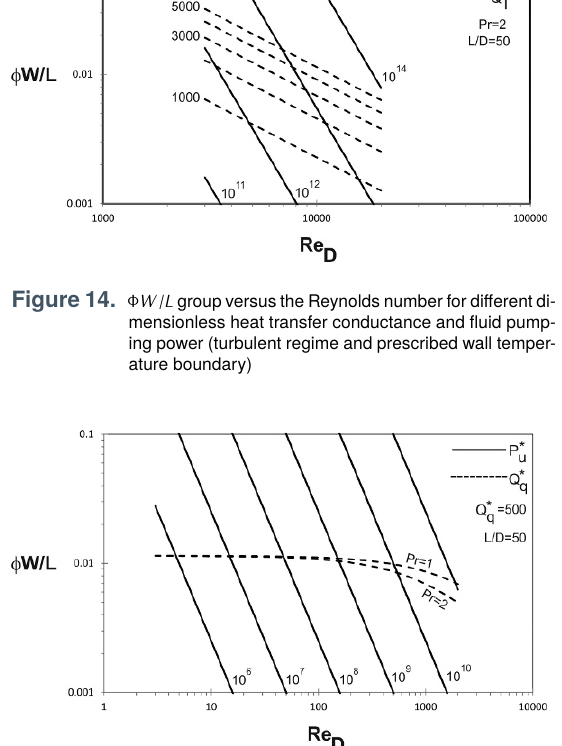
transfer conductance, the pumping power, the Reynolds number, and the Prandtl number.